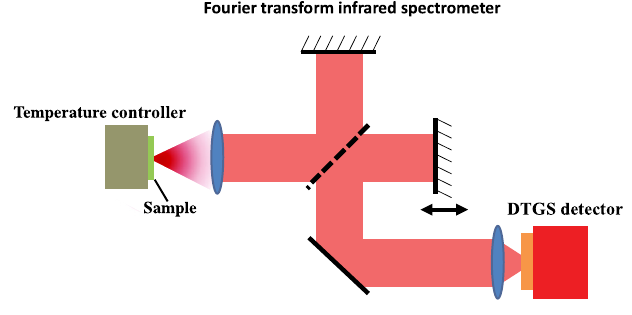
FIG. 1. Experimental setup. The VO 2 -sapphire sample is mounted on a temperature-controlled stage, and the thermal emission is sent into an FTIR spectrometer equipped with a DTGS